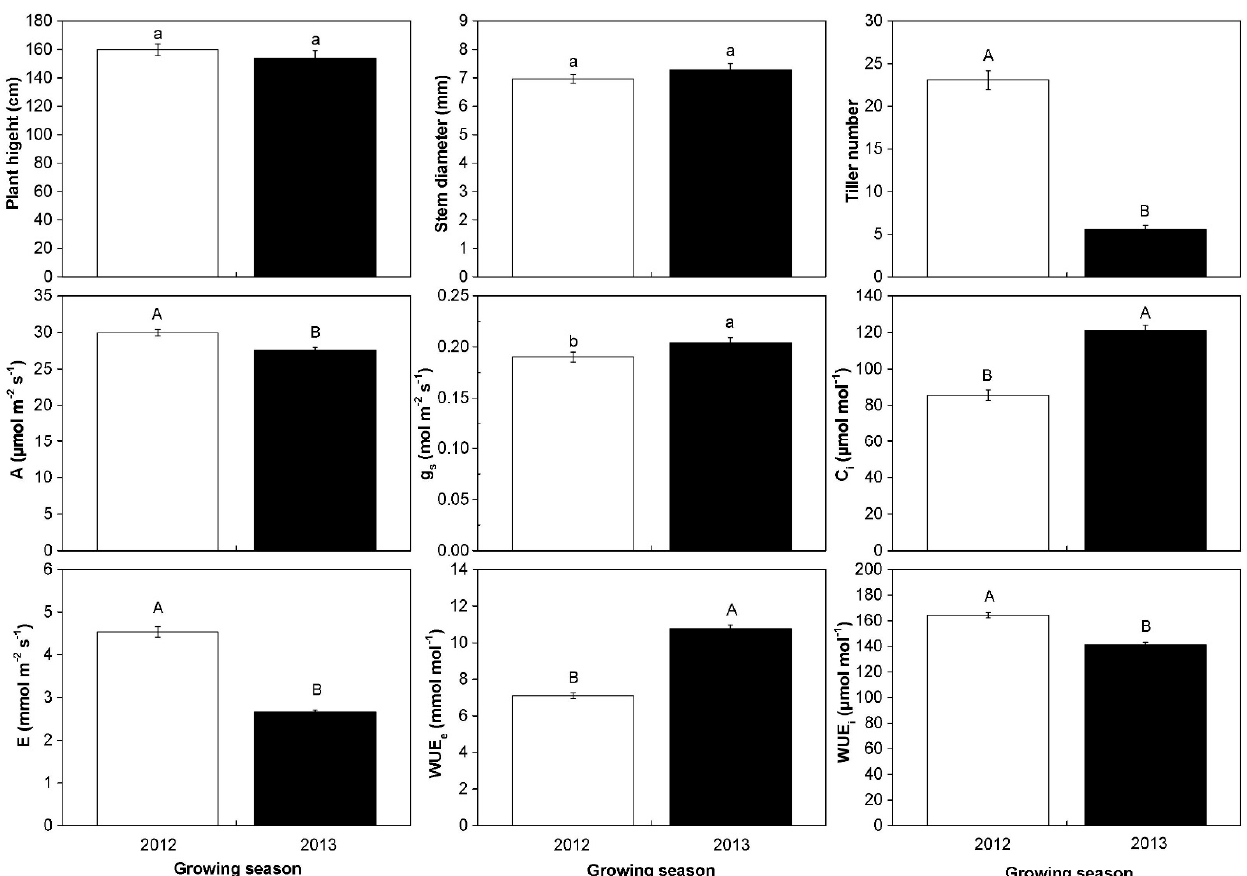
Figure 4. The changes in growth traits, photosynthetic parameters, and water use efficiency when 155 M. lutarioriparius individuals acclimated to the harsh environments from 2012 to 2013. The white bars represent the 2012 growing season (2012) and the black bars represent the 2013 growing season (2013). Mean values and ±SE (error bars) were calculated within 155 surviving individuals. Different lowercases present a significant difference at P < 0.05 level (a, b) and different capital letters present a significant difference at P < 0.01 level (A, B). A: photosynthetic rate; E: transpiration rate; g s : stomatal conductance; C i : intercellular CO 2 concentration; WUE e : extrinsic water use efficiency; WUE i : intrinsic water use efficiency.